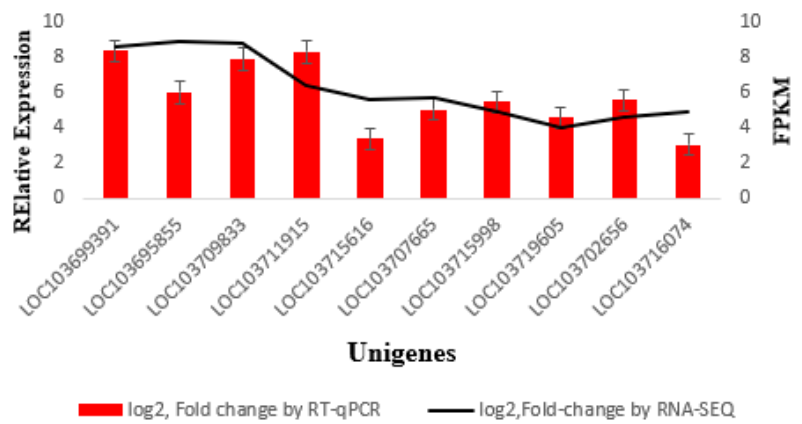
Figure 9. Quantitative real-time PCR analysis and fragments per kilo base million mapped read